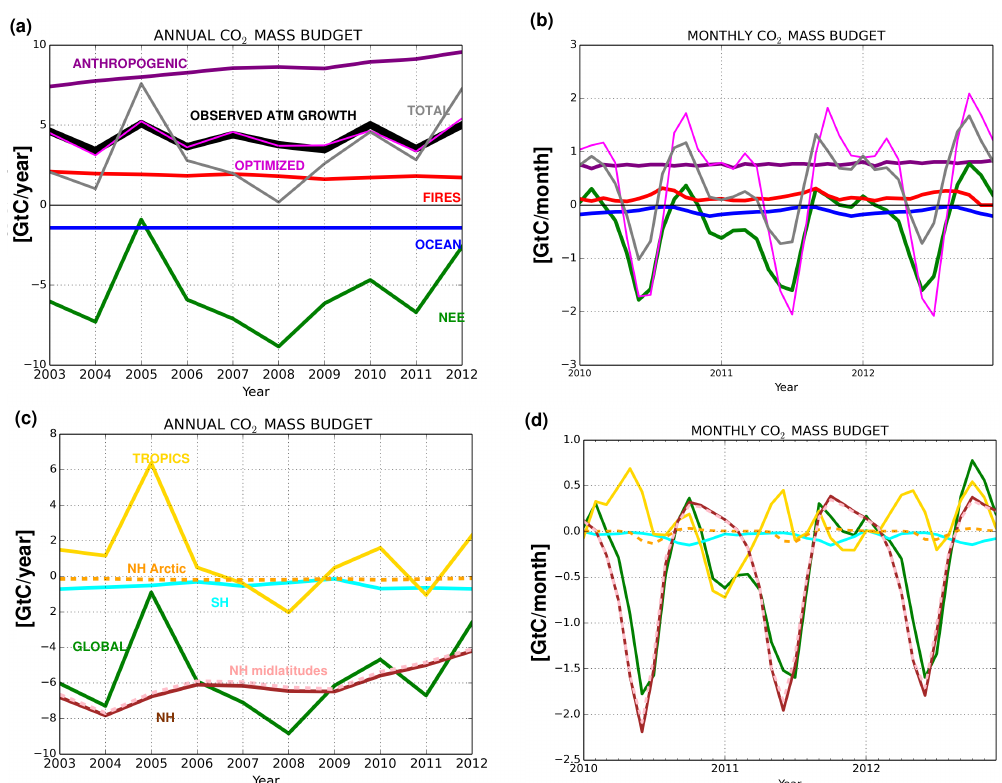
Figure 2. (a) Annual and (b) monthly global CO 2 budget for the modelled total CO 2 flux (grey) compared to the observed CO 2 atmospheric growth from NOAA (black) from 2003 to 2012 and from 2010 to 2012, respectively. The different flux components are shown by the other coloured lines: anthropogenic (purple), fires (red), ocean (blue) and land vegetation (green). The optimized total CO 2 fluxes from Chevallier et al. (2011) are shown in magenta; ( c and d ) depict the NEE annual and monthly budgets, respectively, for different regions: global in green, tropics (between 30 ◦ S and 30 ◦ N) in yellow, Southern Hemisphere (south of 30 ◦ S) in blue, NH (north of 30 ◦ N) in brown, NH mid-latitudes (between 30 ◦ N and 66 ◦ N) in dashed pink and NH arctic (north of 66 ◦ N) in dashed orange.